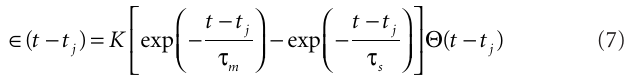
Figure 4 | (A) Maximum capacity α = P / N for a network with 24 3 analog c max neurons, with z connections per neuron, with ϕ * fixed to its optimal value 0.24 π . The red curve corresponds to γ = 0, that is to a network with only short-range connections. The green one to γ = 0.3, and the blue one to γ = 1, that is to a random